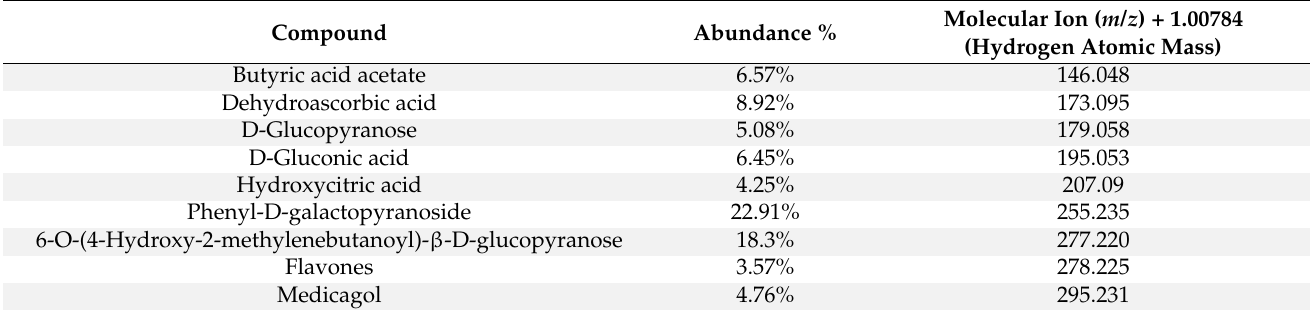
Table 2. Table showing substances obtained by the most important peaks with LC-MS of the hydroal- coholic extract, with relative abundance percentage and molecular ion ( m / z ) + 1.00784 (atomic mass of